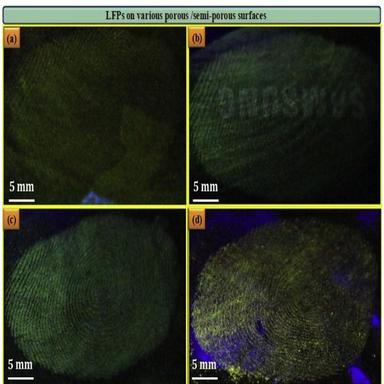
LFPs visualized on various porous/semi-porous/non-porous surfaces by staining CATCL NPs under 254 nm UV light.